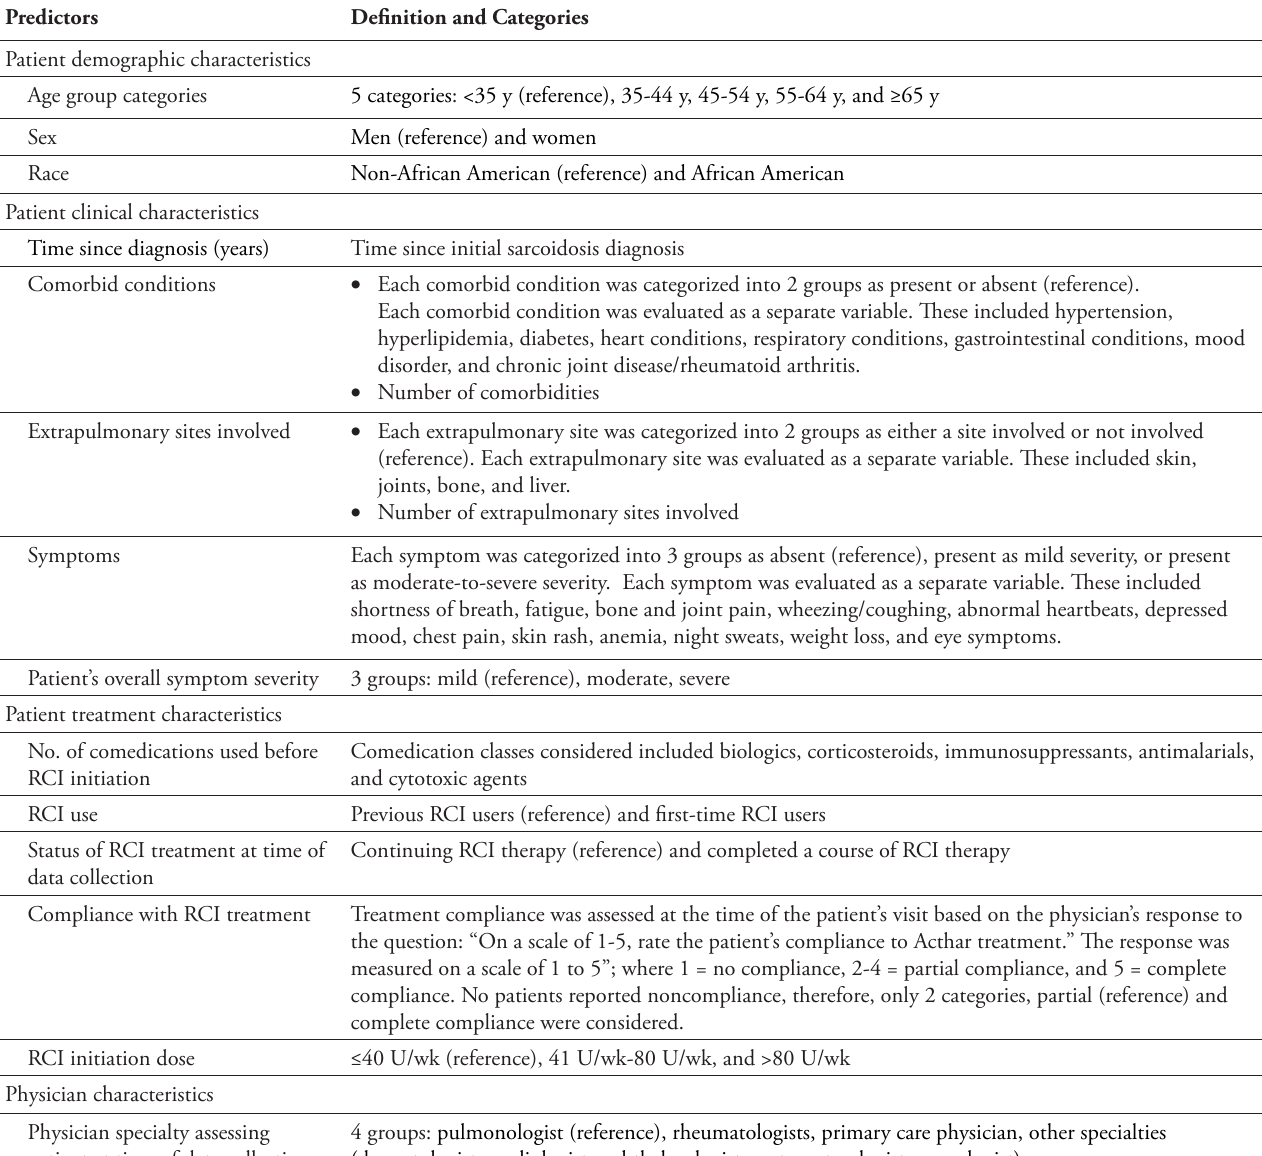
Table 1. Predictors Included in the Unadjusted Logistic Regression Models